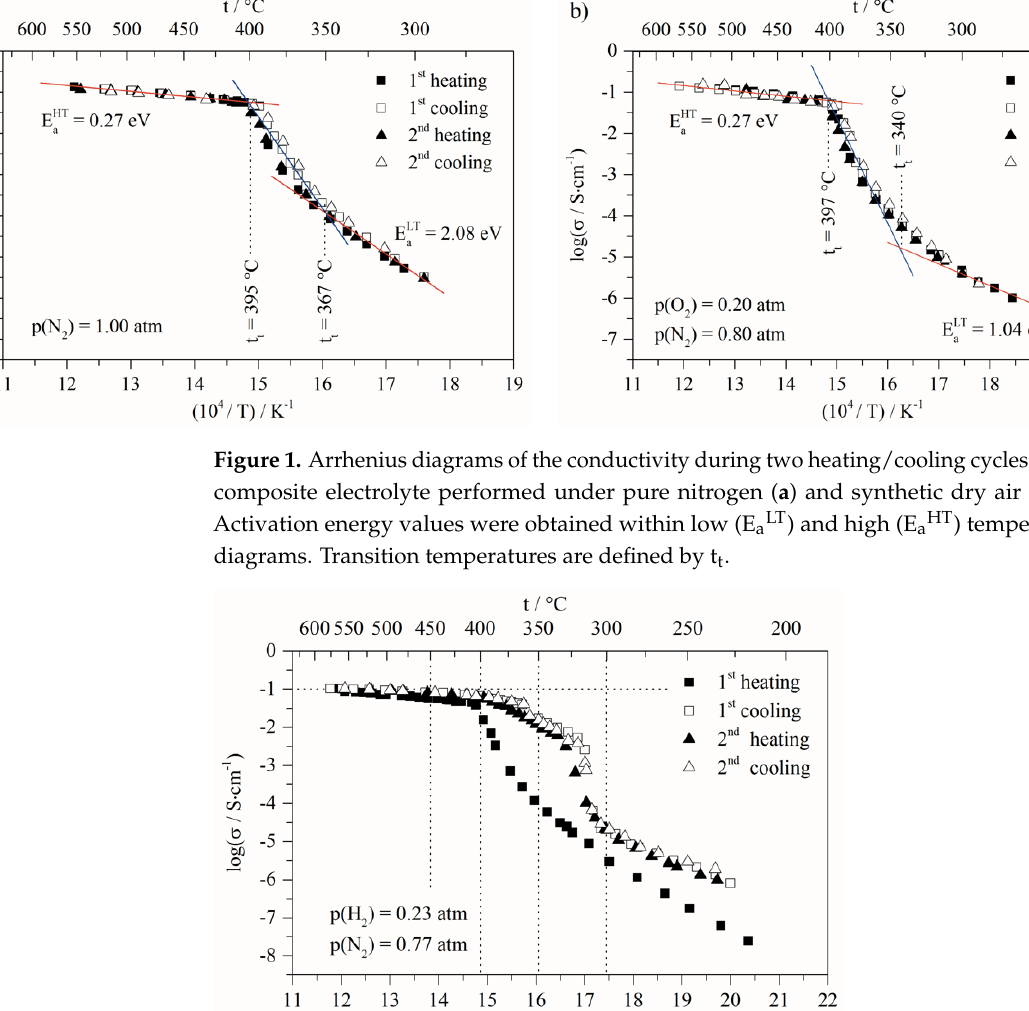
Figure 1. Arrhenius diagrams of the conductivity during two heating/cooling cycles for SDC—LiNaK composite electrolyte performed under pure nitrogen ( a ) and synthetic dry air ( b ) atmospheres. Activation energy values were obtained within low (E aLT ) and high (E aHT ) tempera- ture regions of diagrams. Transition temperatures are defined by t t .